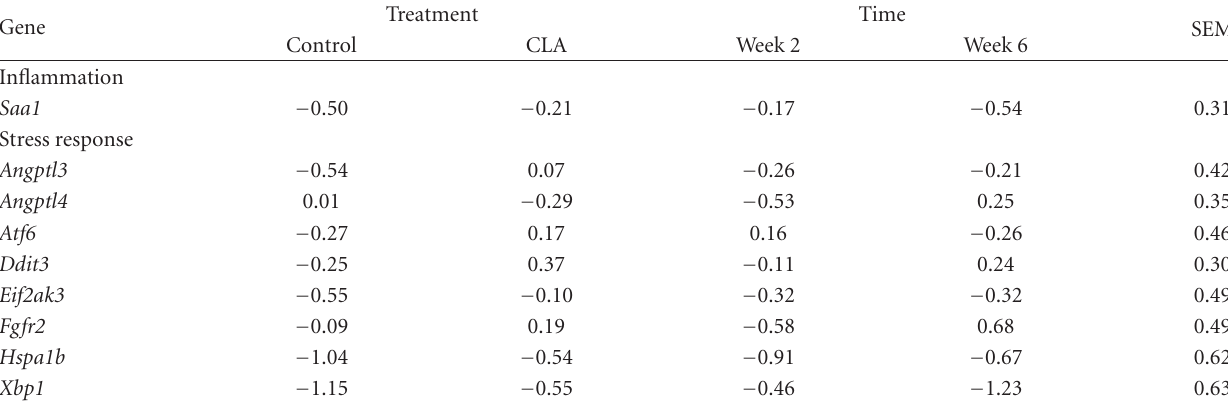
Table 6: Hepatic expression of genes related to inflammation and cellular stress in mice fed control or the control supplemented with trans - 10, cis -12-CLA (CLA). There were no significant interactions of treatment × time. Therefore, the results are presented according to main e ff ects (treatment and